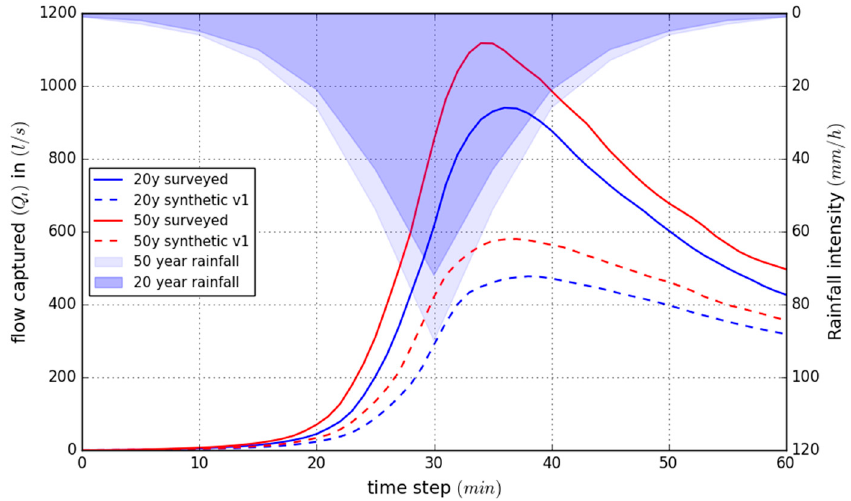
Figure 4. Comparison of flow captured (Qi) for surveyed and synthetic storm drain inlet network version 1 for a 20 and 50 year storm event.